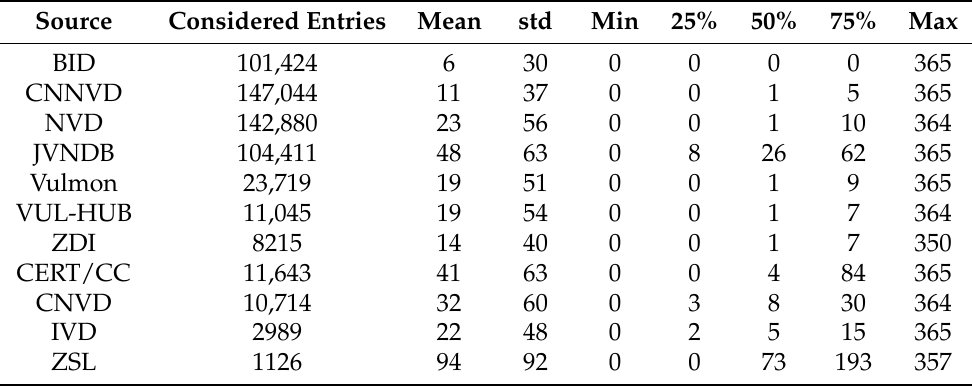
Figure 6. Number of entries in the high database with given delay (shorter than 365 days) between first and last source publishing information about vulnerability presented as a histogram and a box plot. Highlighted are: minimum = 0 days, maximum = 365, median = 24 and quartiles 1 and 3 (7 and 61 days respectively). Table 4. Release dates delays statistics for sources. Mean, standard deviation (std), minimum (min), maximum (max) and percentiles (25%, 50%, 75%) are in